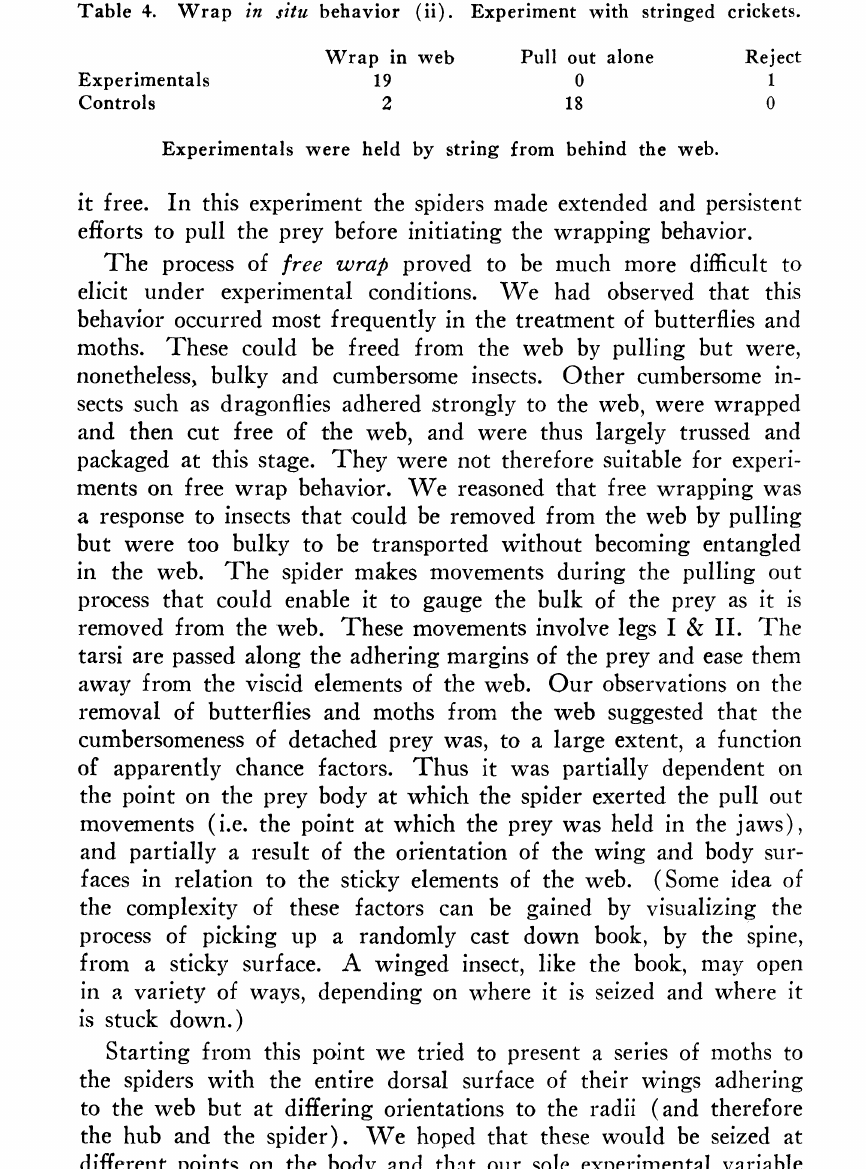
Table 4. Wrap in situ behavior (if). Experiment with stringed crickets. Wrap in web Pull out